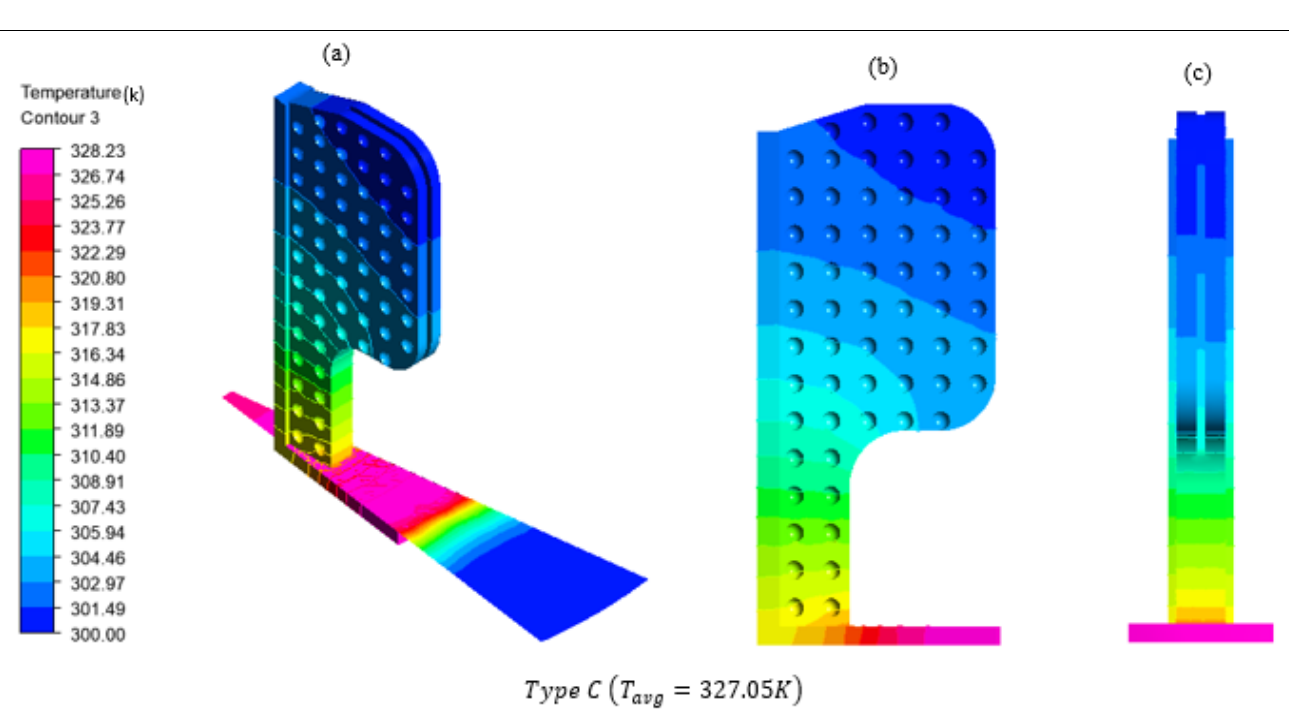
Figure 11: Temperature contour plot of the Type C radial HS at 𝑞̇ = 190 0 𝑊/𝑚 2 for (a) 3D view of Type C (b) Side view of Type C (c) Frontal view of Type